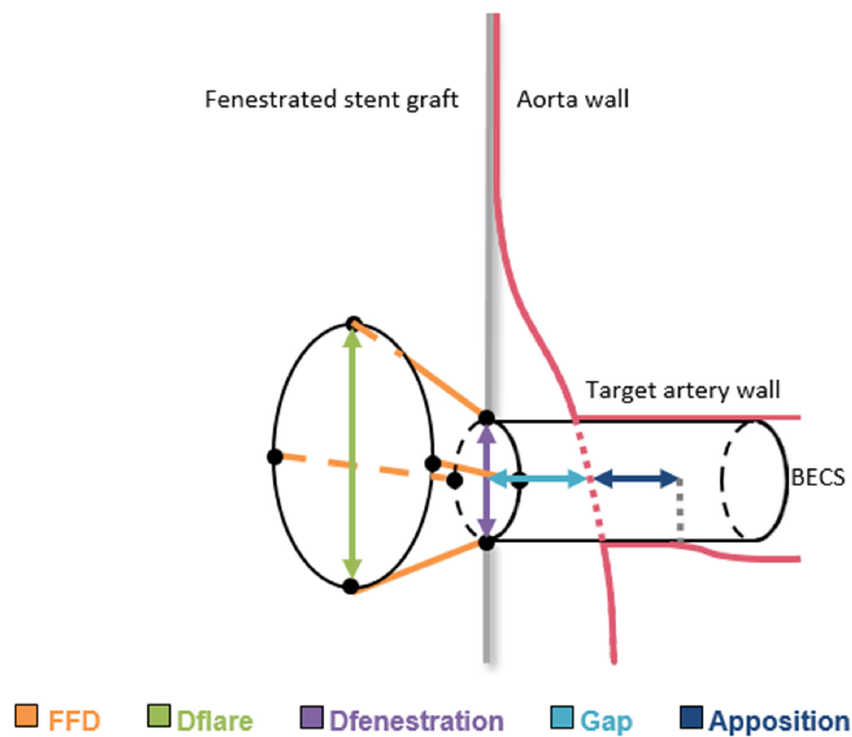
Figure 1. Schematic presentation of the fenestrated stent graft (FSG) in the aorta and the balloon- expandable covered stent (BECS) connecting the target artery to the FSG. The geometric parameters, flare-to-fenestration distance (FFD), diameter of the flare (Dflare), and diameter of the fenestration (Dfenestration), gap distance (gap), and circumferential apposition (apposition) quantify BECS geometry.